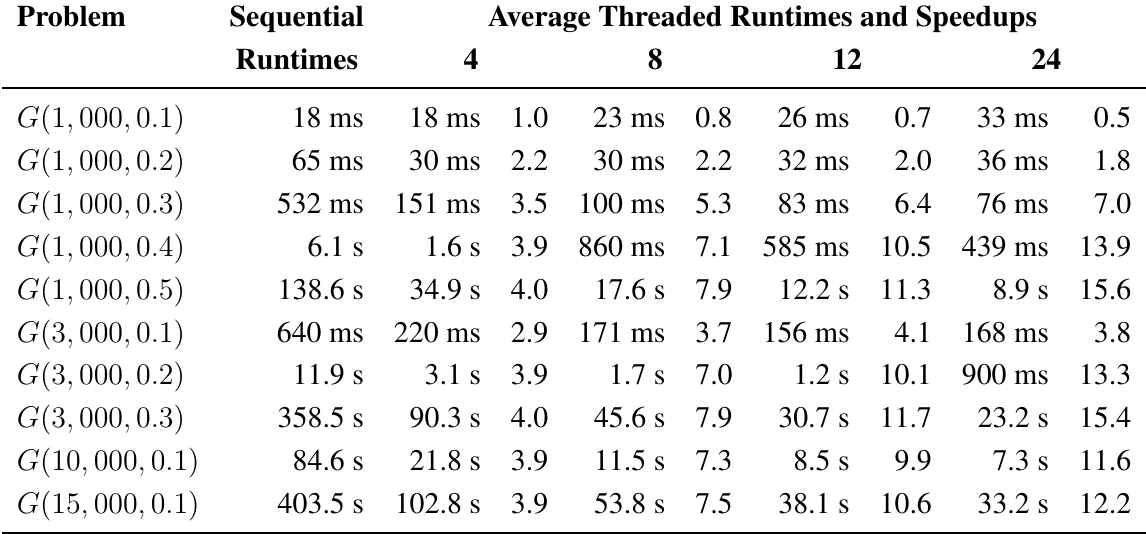
Table 4. Experimental results for larger, sparser random graph instances, sample size of